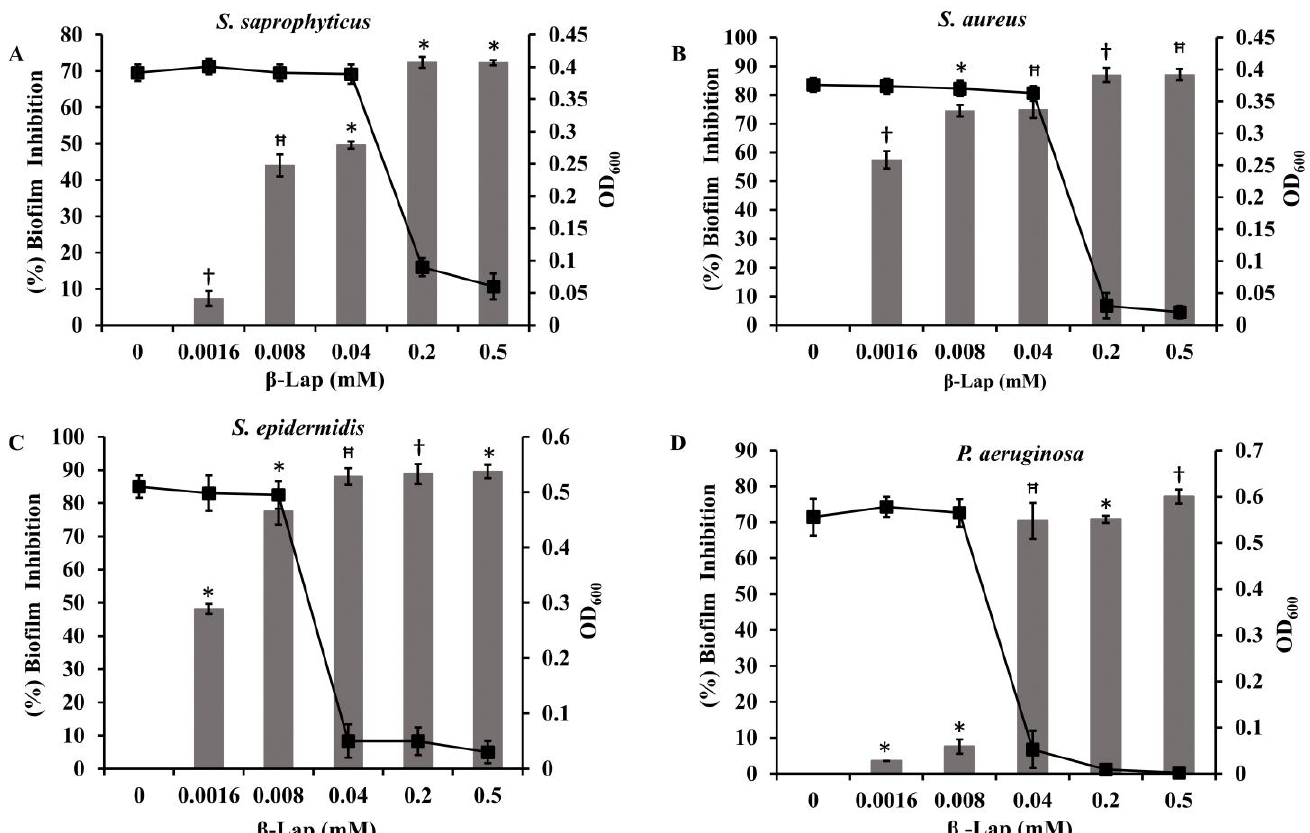
Figure 7. Inhibition of biofilm formation by β-Lap: The growth and the biofilms formed by bacterial cultures at different concentration of β-Lap were estimated by crystal violet absorbance at 570 nm and optical density at 600 nm, respectively. The calculation for % inhibition of biofilm formation is discussed in Materials and Methods section. The growth curve and bar graph for biofilm inhibition (%) were constructed for each bacterial strain of ( A ) S. saprophyticus , ( B ) S. aureus , ( C ) S. epidermidis , and ( D ) P. aeruginosa . Line: Growth curve, Bar: Biofilm inhibition. *; p 0.002, †; p 0.004, ꟸ ; p 0.007.